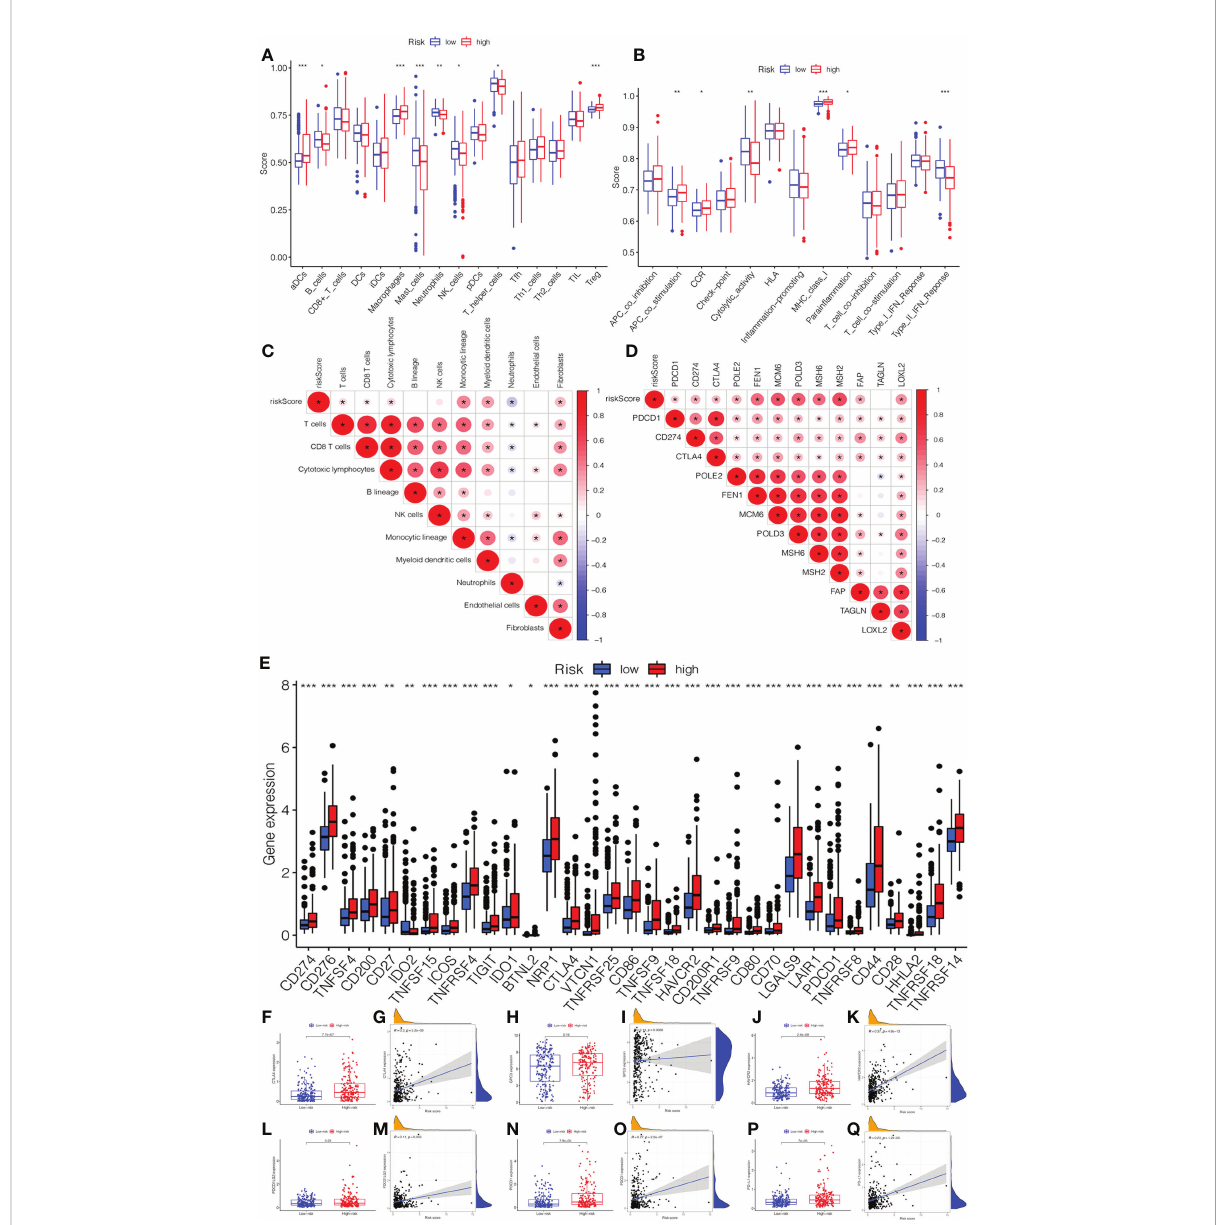
FIGURE 6 The association of immune in fi ltration and immunotherapy response with the prognostic signature. (A) The in fi ltrating levels of 16 subtypes of immune cells in low- and high-risk groups. (B) The expression of 13 immune functions in low- and high-risk groups. (C) The correlation between the risk score and immune in fi ltration cells. (D) The expression of the immune checkpoints of low- and high-risk groups. (E) The correlation between the risk score and immune checkpoint genes. The expression and correlation between the risk score and immune checkpoint inhibitors: (F) CTLA4. (G) GPC3. (H) HAVCR2. (I) PDCD1LG2. (J) PDCD1. (K)